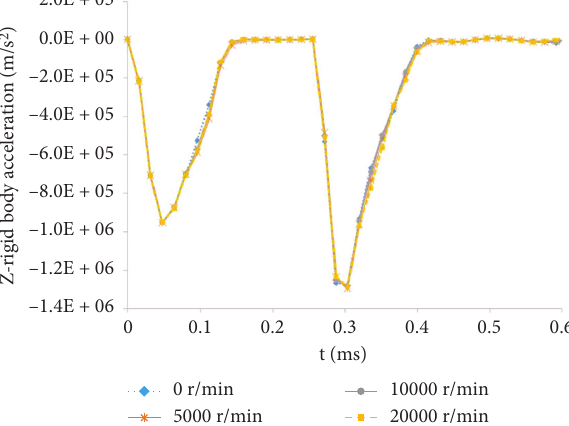
Figure 10: Invasive acceleration graph when the speed changes.